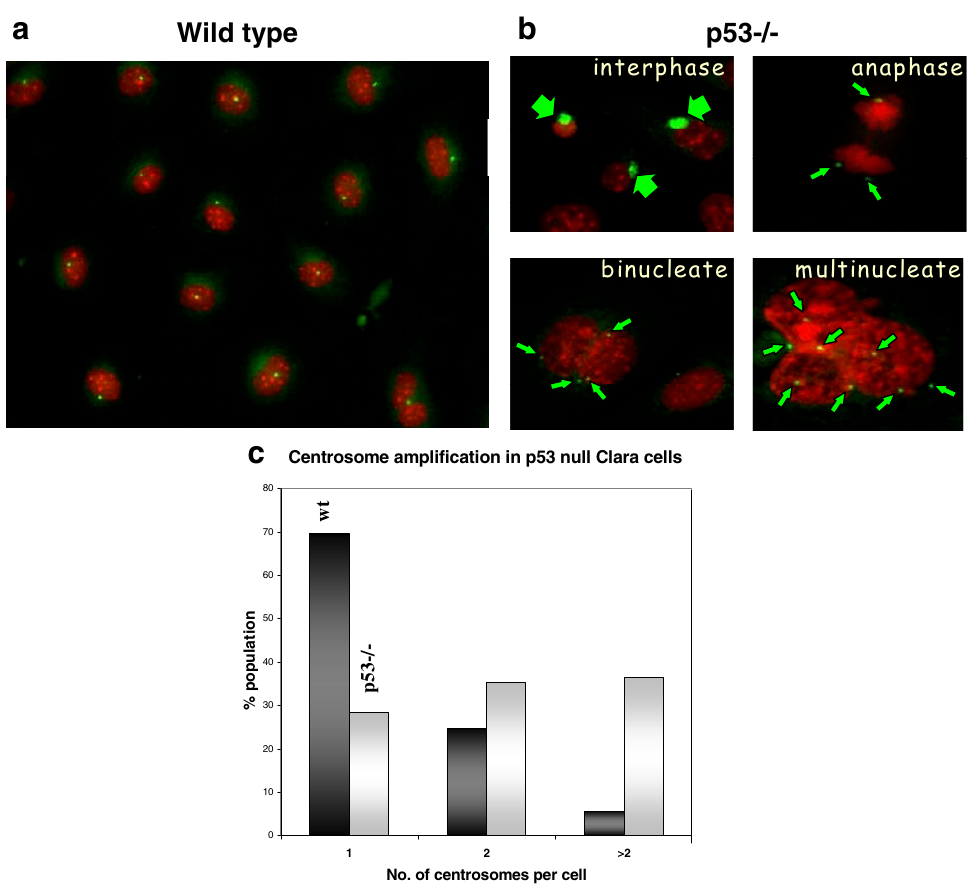
Figure 3 Centrosome amplification in p53-/- Clara cells Confocal micrographs of wild type and p53-/- Clara cell cultures immun- oflourescently labelled with anti-pericentrin (green) and counterstained with propidium iodide (red). a) Single centrosomes were predominantly observed in wild type cells. b) In p53-/- cultures, more than two centrosomes and/or clusters of pericen- trin-staining material were frequently observed in interphase, mitotic (anaphase), and multinucleated cells. Top left) Interphase Clara cells displaying clumps of pericentriolar material (thick arrows) and a single nuclei. Top right) Anaphase Clara cell with 3 centrosomes (thin arrows) forming a tripolar spindle. Bottom left) Binucleated Clara cell displaying 4 centrosomes (thin arrows) unevenly distributed between the two nuclei. Bottom right) Multinucleated Clara cell with 3 nuclei and 8 centrosomes (thin arrows). Panel c) exhibits the effects of p53 on centrosome number in 48-hour Clara cell